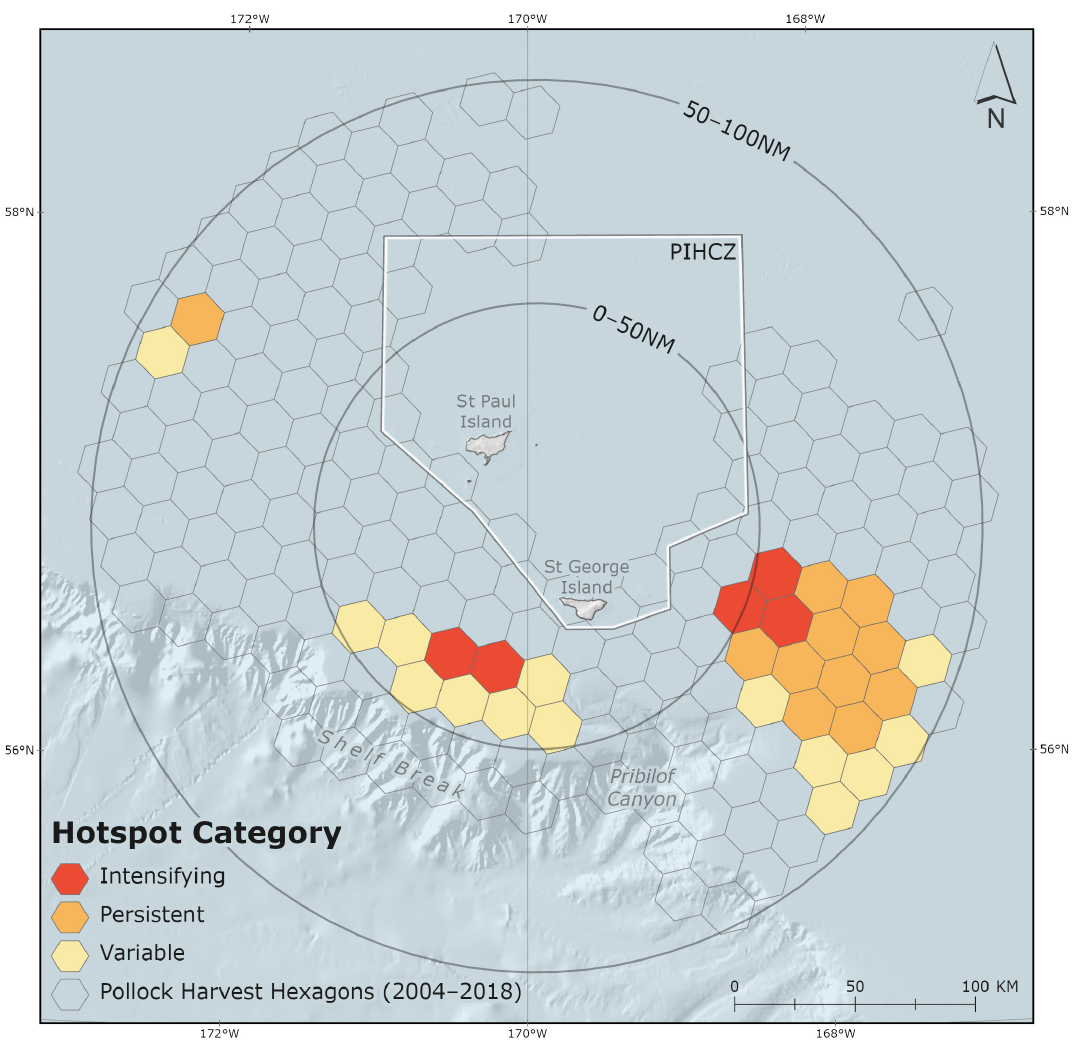
Figure 5. Three hotspot areas, categorized as intensifying, persistent, and variable, identified in the Pribilof Islands Marine Ecosystem (PRIME). The Pribilof Islands Habitat Conservation Zone (PIHCZ) is pictured.